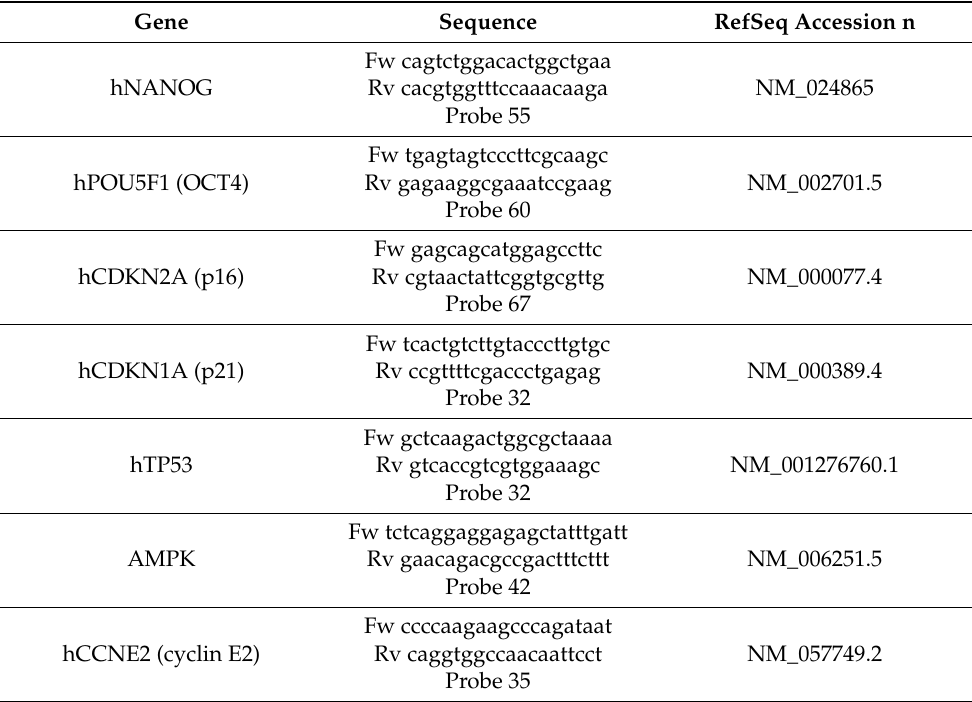
Table 1. The list of primers used in the